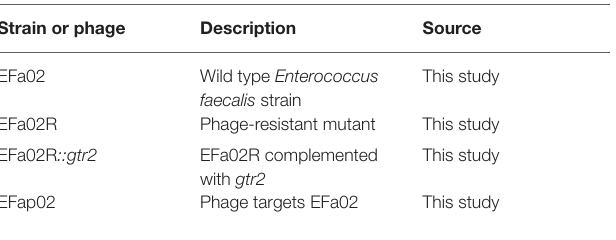
TABLE 1 | Bacterial strains and phages used in this